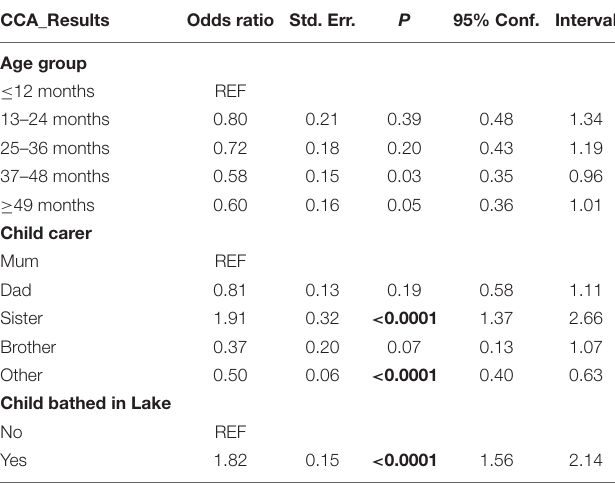
TABLE 5 | Association between behavioral factors and